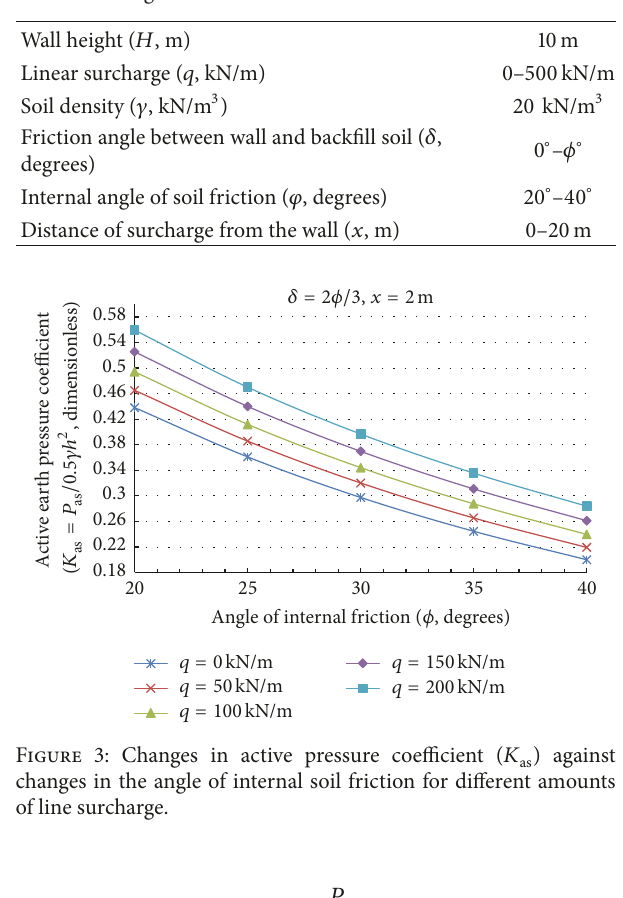
Table1:Thefeaturesofthesamplewallintheanalyseswiththeeffect of line surcharge.